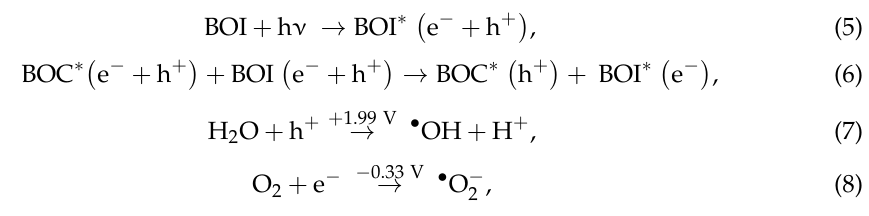
Figure S4: FESEM image of (a) BOC/BOI-3 composite and (b) its corresponding EDS sum image consists of four different colors: light red, dark red, green, and blue; these denote the presence of (c) Bi, (d) O, (e) Cl, and (f) I in the BOC/BOI-3 heterostructure, respectively (g) EDS spectrum of BOC/BOI-3 composite, with the inset table showing the atomic and elemental weight percentages of BOC/BOI-3 nano composite; Figure S5: XPS survey spectra for BOC, BOI, and BOC/BOI-based photocatalysts; Figure S6: Time-resolved absorption spectra of RhB degradation with (a) BOC, (b) BOI, (c) BOC/BOI-1, (d) BOC/BOI-2, (e) BOC/BOI-3, and (f) BOC/BOI-4 photocatalysts; Figure S7: Pseudo-first-order reaction kinetic plots of BOC, BOI, BOC/BOI-1, BOC/BOI-2, BOC/BOI-3, and BOC/BOI-4 photocatalyst for RhB degradation; Figure S8: Time-resolved absorption spectra of RhB degradation with (a) BOC, (b) BOI,(c) BOC-BOI-3, and (d) Pseudo-first-order reaction kinetic plots of BOI, BOC, and BOC/BOI-3; Figure S9: (a) Degradation efficiency with reaction rate constant and (b) 1st order reaction kinetics plot of RhB with and without scavengers in the presence of BOC/BOI-3; Figure S10: NBT degradation in the presence of (a) BOC, (b) BOI, and (c) BOC/BOI-3; (d) Chemical reaction for conversion of p-Nitroblue tetrazolium Chloride (NBT) to Formazan in the